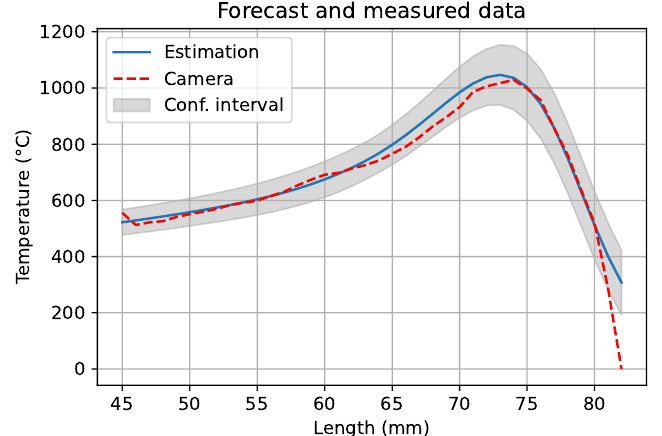
Figure 14. Camera data of the future state.